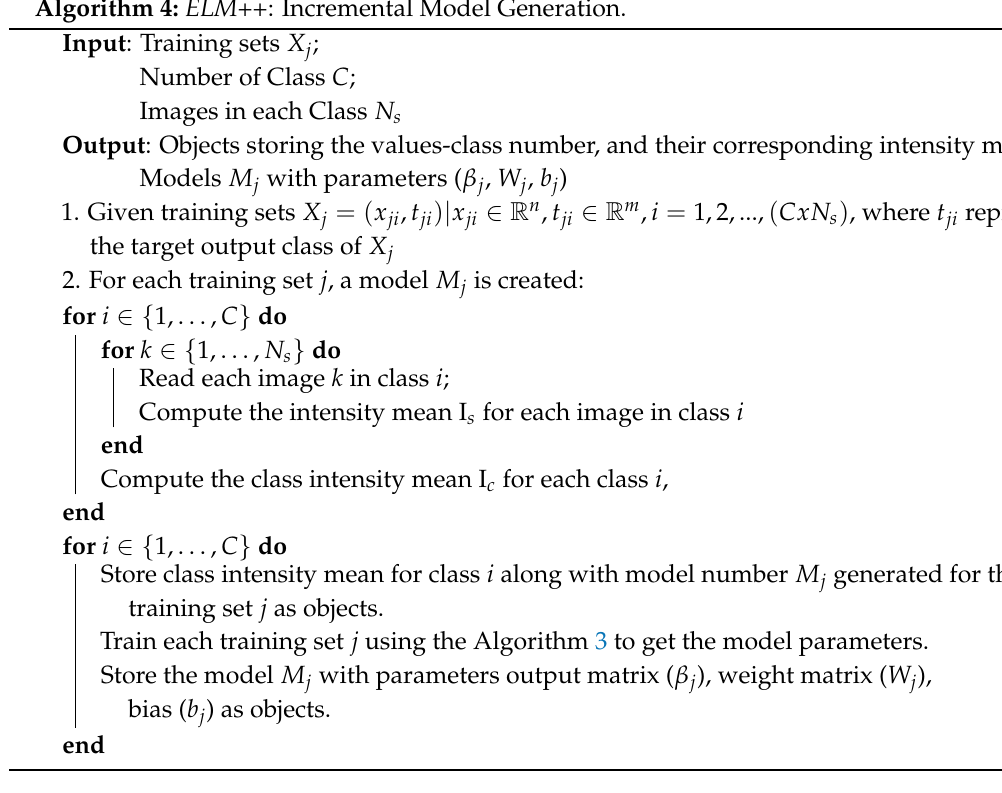
Algorithm 4: ELM++ : Incremental Model